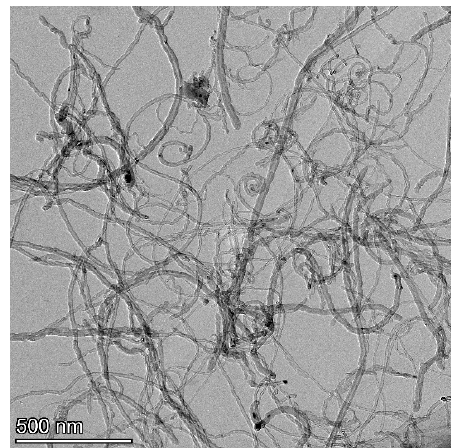
Figure 3. TEM of MWCNTs.